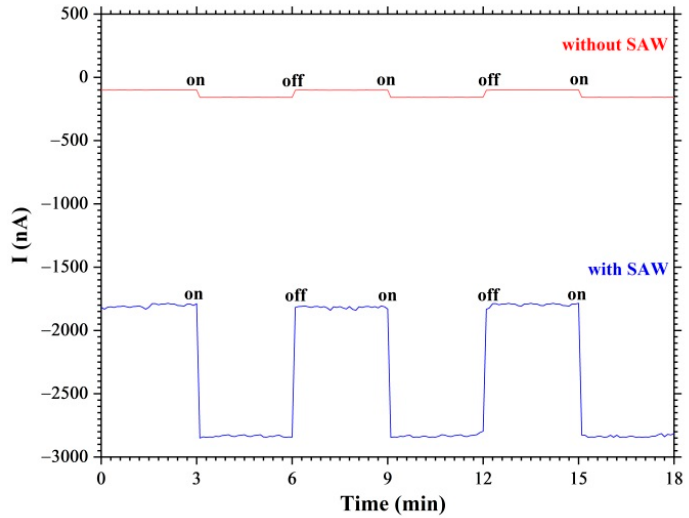
Figure 8. Dependences of acoustically stimulated photocurrent in graphene film on the on/off switching of the surface acoustic wave.